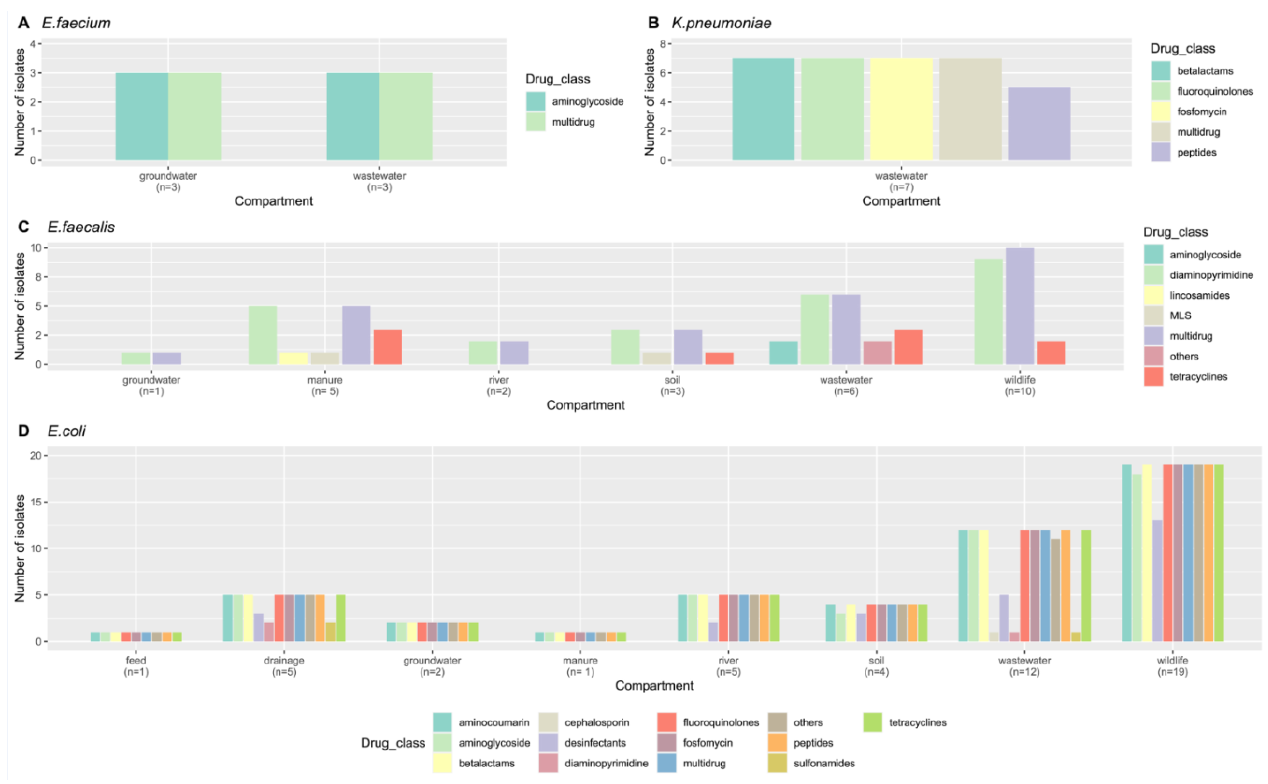
Figure 2. Number of isolates obtained in each species ( A - E. faecium , B - K. pneumoniae , C - E. faecalis , D - E. coli ) and compartment, harboring ARGs allocated to different drug classes.